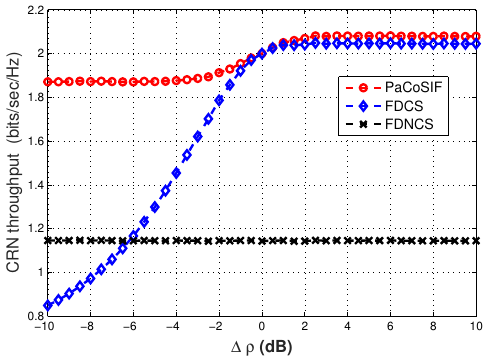
Figure 11. CRN throughput in spectrum-heterogeneous